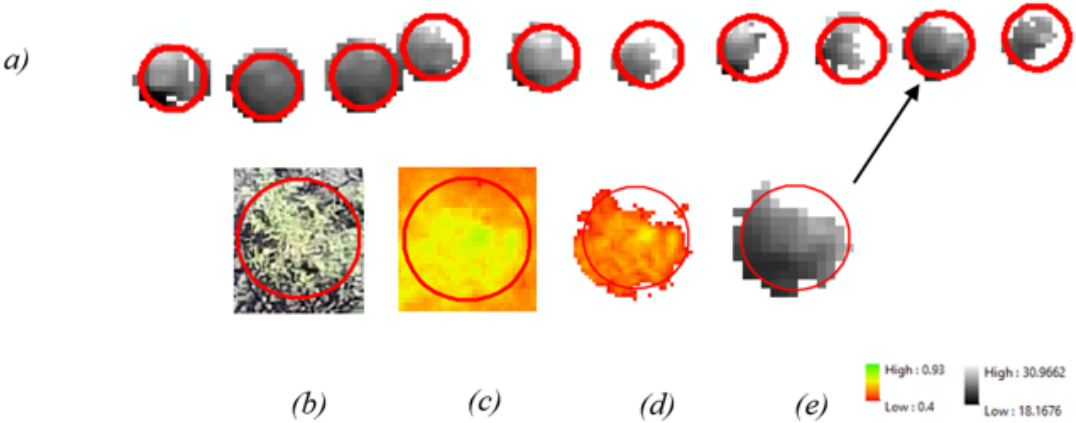
Figure 2. The complete extraction process: ( a ) Extracted thermal data from kochia at the Casselton location. ( b ) RGB image of kochia for reference. ( c ) NDVI of kochia prior to 0.4-pixel value extraction. ( d ) NDVI mask containing pixels that score over 0.4 ( e ) NDVI mask applied to thermal data.